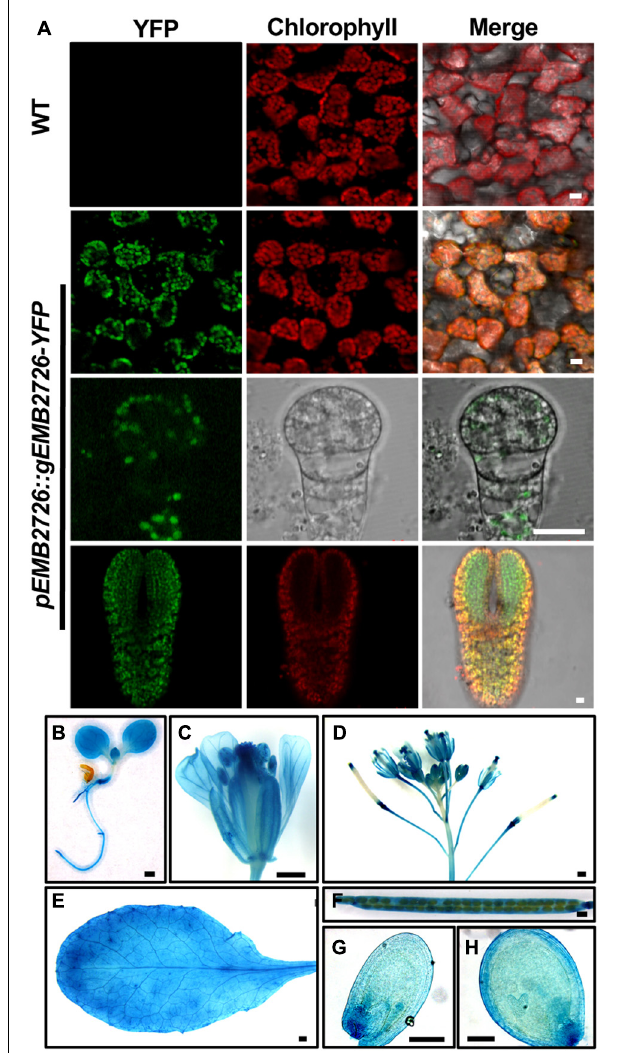
FIGURE 3 | Subcellular and tissue localization of EMB2726. (A) Localization of EMB2726 using a pEMB2726:gEMB2726-YFP stable transgenic line. The top two rows show the subcellular localization of EMB2726-YFP in mesophyll cells with WT as control (top row). The third and fourth rows show the localization in octant and torpedo stage embryos, respectively. Scale bar = 10 µ m. (B–H) GUS staining results using pEMB2726:gEMB2726-GUS transgenic plants. (B) A 7-day-old seedling; (C) flower; (D) inflorescence; (E) rosette leaf; (F) mature silique; (G) early globular seed; and (H) heart stage seed. Scale bar = 0.5 mm (B–F) and Scale bar = 0.1 mm (G,H)